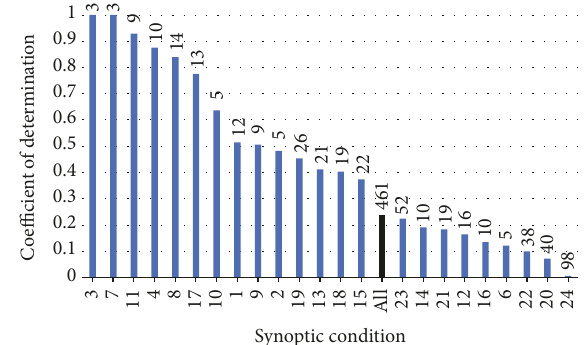
Figure 13: Coefficient of determination for the multiple regression modelfortheAyiaMarinastation,foreachoftheprevailingsynoptic conditions (1–24) and for all cases irrespective of the synoptic condition (shown as All). The synoptic conditions are ranked on the basis of the value of the coefficient of determination, from the maximum (left) to the minimum (right) value. The number given above each bar is the number of the available data pairs for the respective synoptic